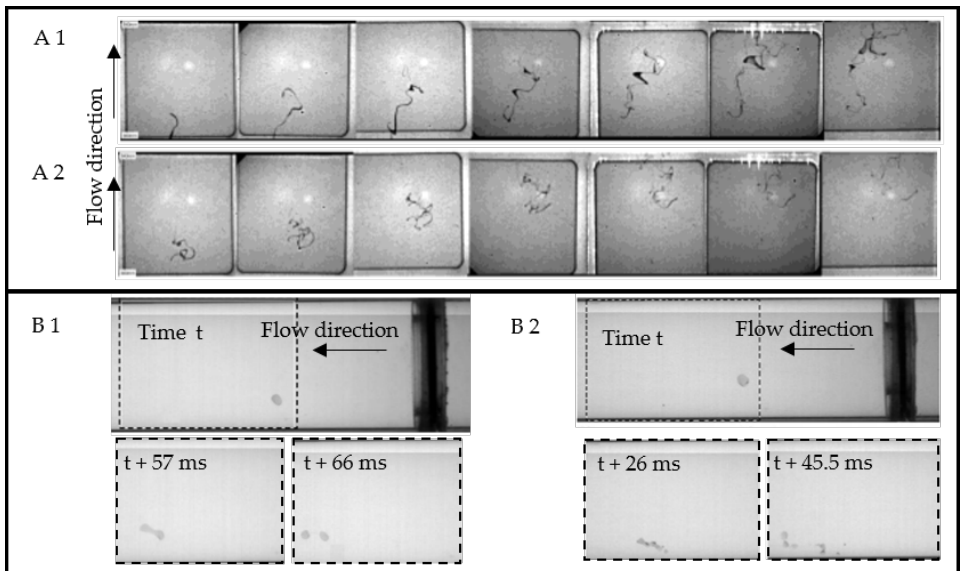
Figure 2. ( A ) A sequence of droplet break-up at a constant Reynolds number of Re = 1570 from [24]: ( A1 ) the droplet break-up at a viscosity ratio of λ = 0.13; and ( A2 ) the droplet break-up at a viscosity ratio of λ = 6.3. Reproduced with the permission from [24]; Wiley, 2002. ( B ) The droplet break-up in an orifice at a constant viscosity ratio of λ = 0.55: ( B1 ) the droplet break-up into two daughter droplets at a Reynolds number of Re = 6400; and ( B2 ) the droplet break-up into several daughter droplets at a Reynolds number of Re = 8600. Reproduced with the permission from [27]; Elsevier, 2005.